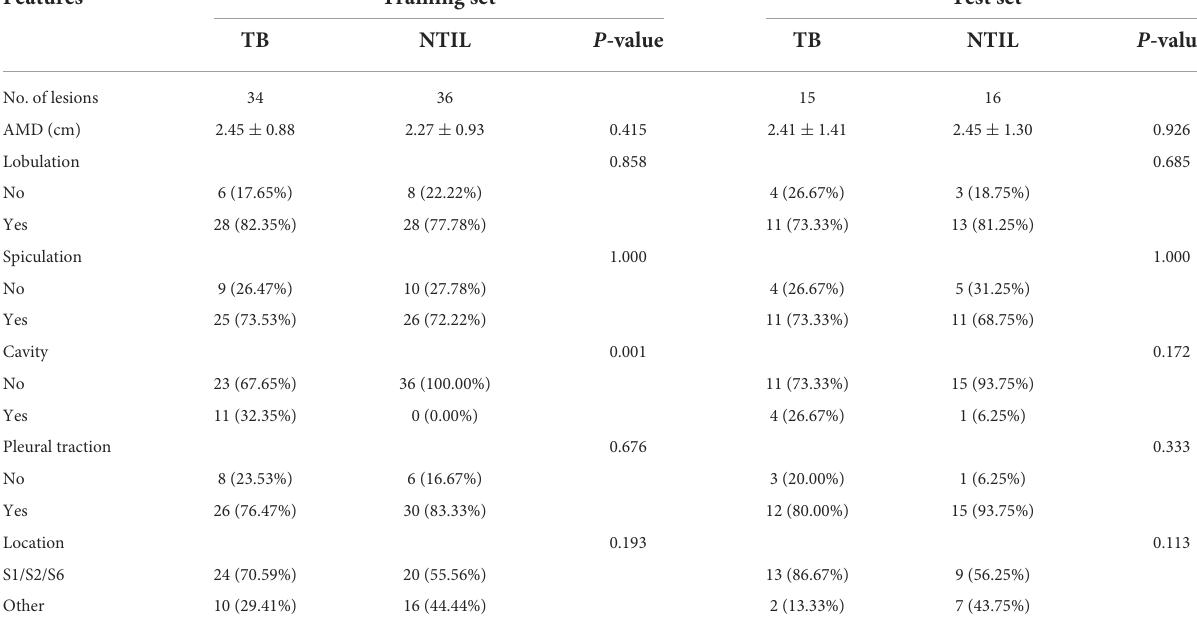
TABLE 2 The comparison of conventional imaging features between two groups. Features